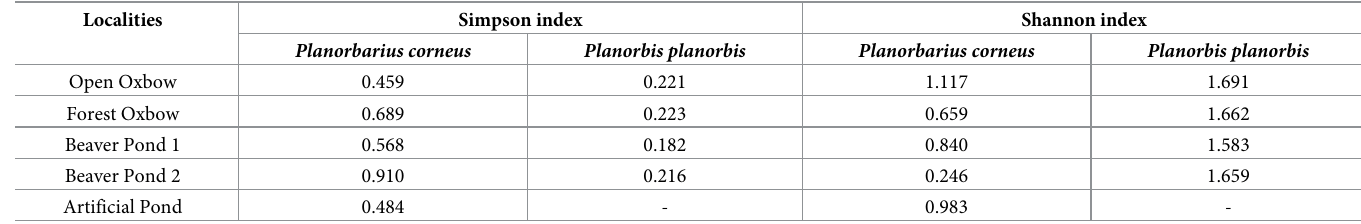
Table 5. Diversity indices for species of trematodes from Ostrovtsovskaya Lesostep’ waterbodies.